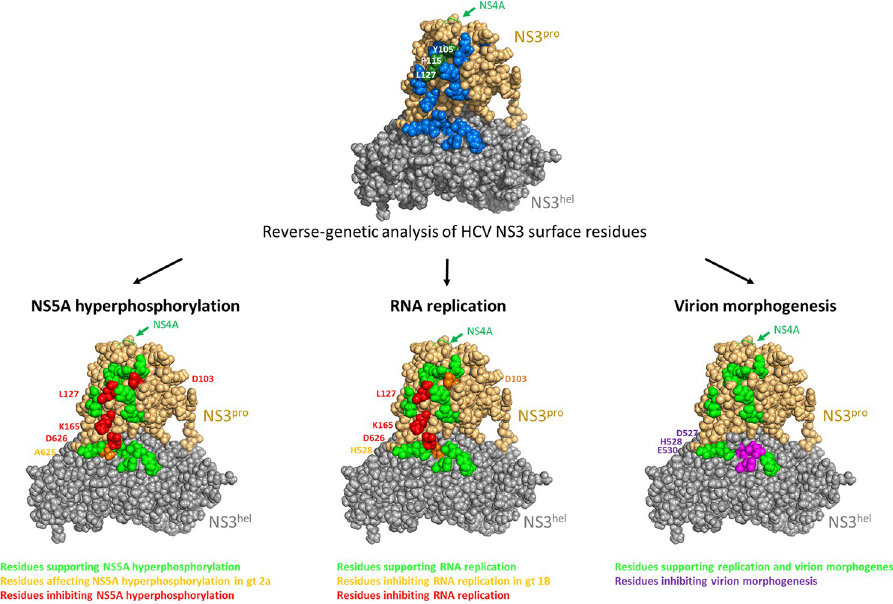
Fig 8. Summary of the reverse-genetics characterization of a multipurpose NS3 Surface patch coordinating HCV replicase assembly and virion morphogenesis. NS3 surface residues important for NS5A hyperphosphorylation, RNA replication or virion morphogenesis are highlighted in red or purple. The exit position of the NS4A cofactor is indicated by a green arrow.